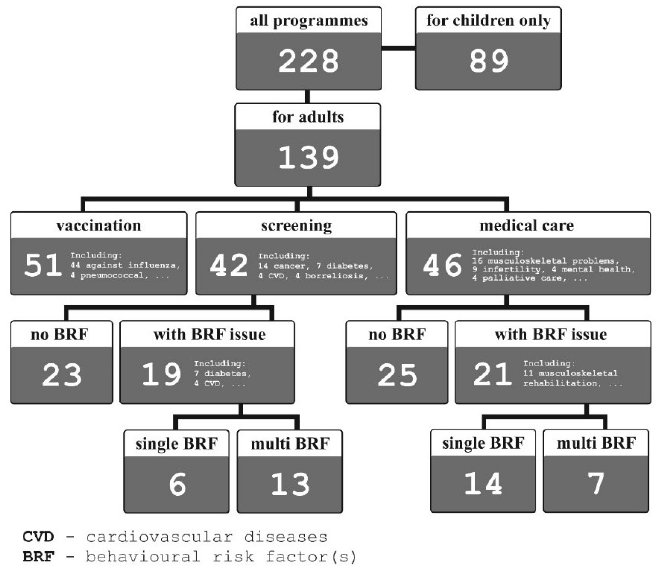
Figure 3. The number and nature of Polish health programmes submitted for assessment of AOTMiT in